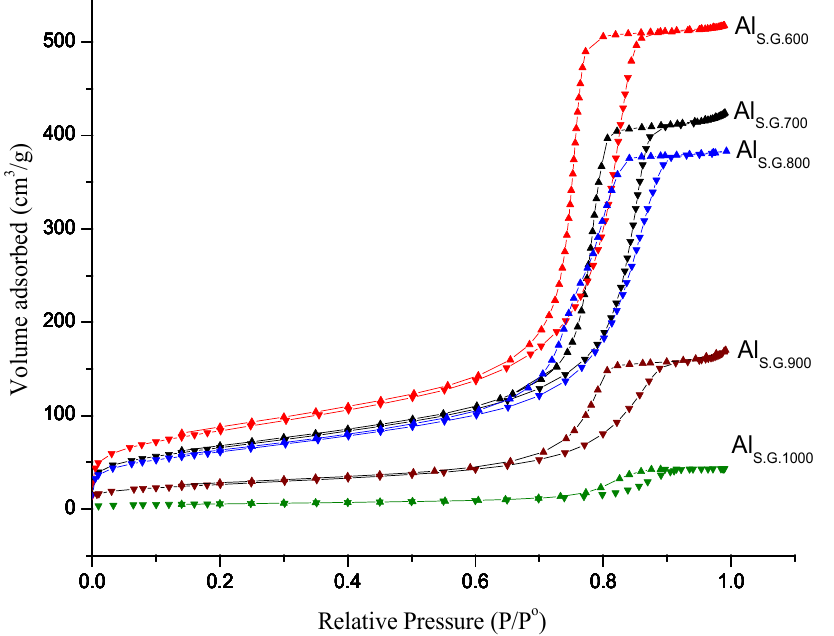
Figure 1. Nitrogen adsorption–desorption isotherms for sol gel alumina supports at different calcinations temperature.